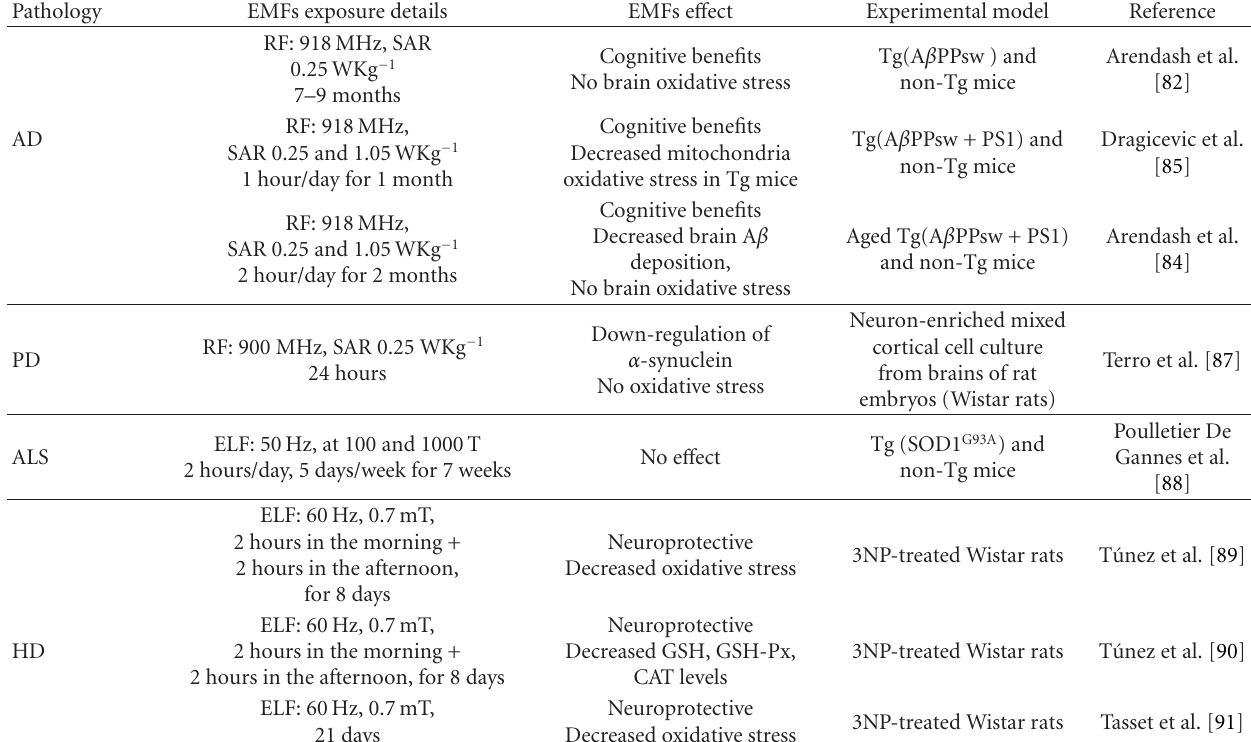
Table 2: EMFs e ff ects on oxidative stress and neurodegeneration: in vitro and in vivo experimental